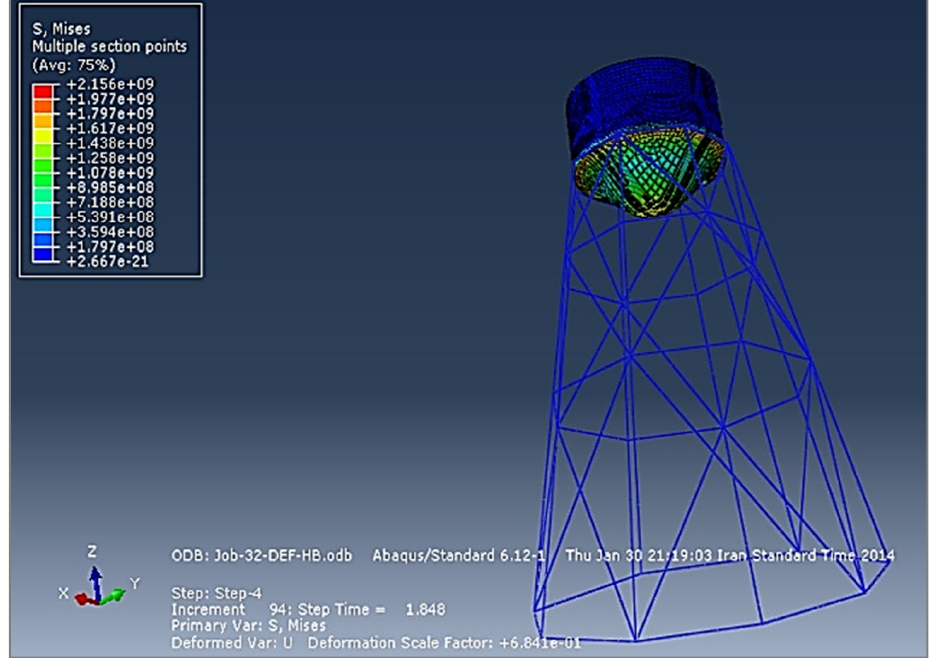
Figure 20. Stress in a flexible elevated storage tank equipped with a horizontal baffle.